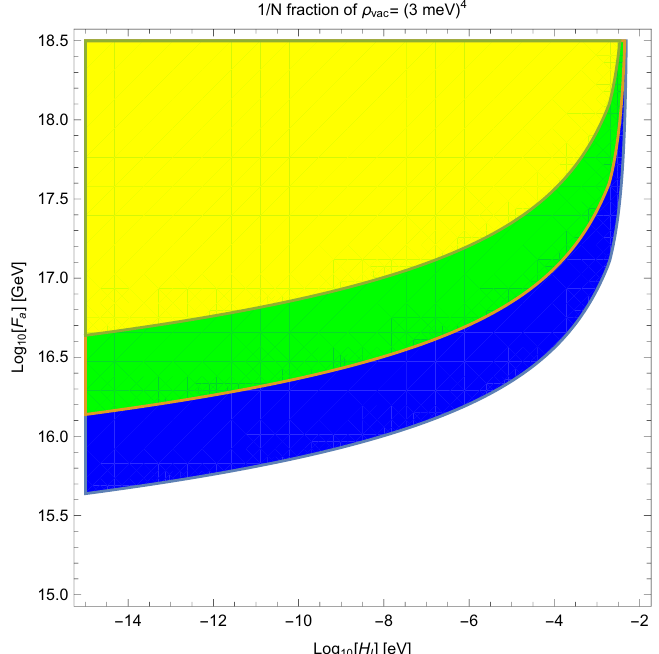
Figure 5 . Parameter space allowed for N -essence, defined as δθ i . δθ max (see eq. (4.18)). Different colors correspond to light axions composing a different fraction of the observed dark energy. The lower is H , the lower can be the axion decay constant F . The yellow region corresponds to I a N = 1 , the green N ≤ 10 , the blue N ≤ 100 . We see that a moderate number of axions N = O (10) already allows a decay constant F a ∼ M GUT and an inflationary Hubble parameter H I ∼ O (0 . 1 − 1) meV. Assuming instantaneous reheating, this corresponds to a reheating temperature of T RH ∼ O (0 . 1 − 1) TeV, i.e. around the weak scale. As in the case of single axion quintessence, the plotted regions satisfy the current bound to the equation of state parameter: w . − 0 . 95